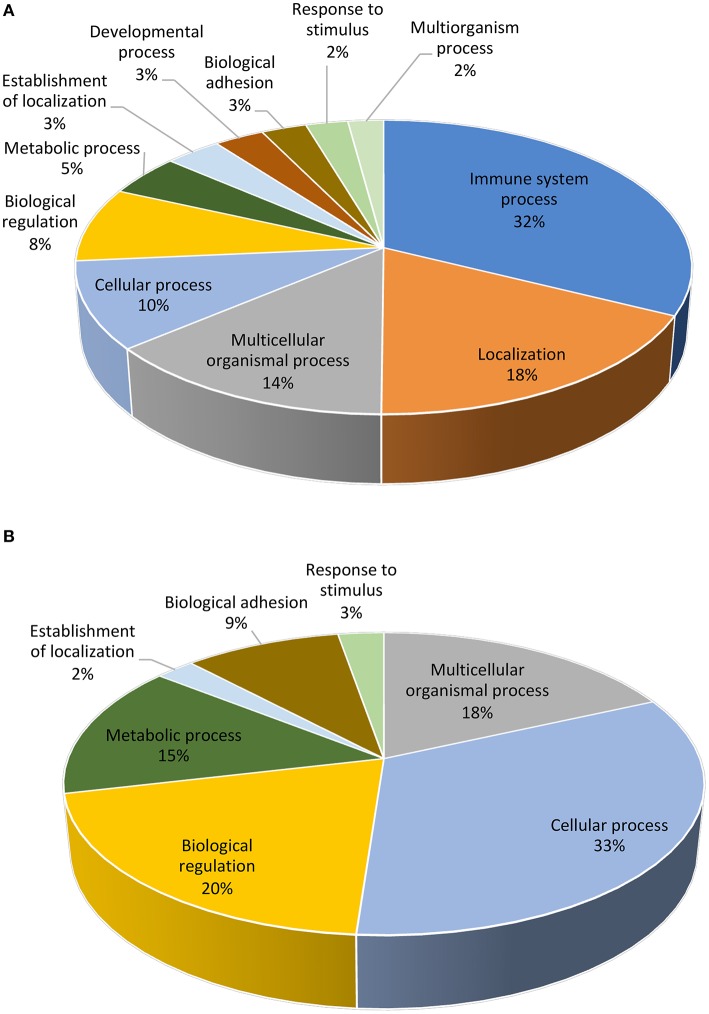
Functional distribution (KEGG database) of transcripts. The differentially expressed (P < 0.05) genes represented correspond to the distal (A) or proximal (B) regions of the uterine horn endometrium 6 days after heterologous seminal plasma (SP) or BTS (control) infusions prior to insemination.